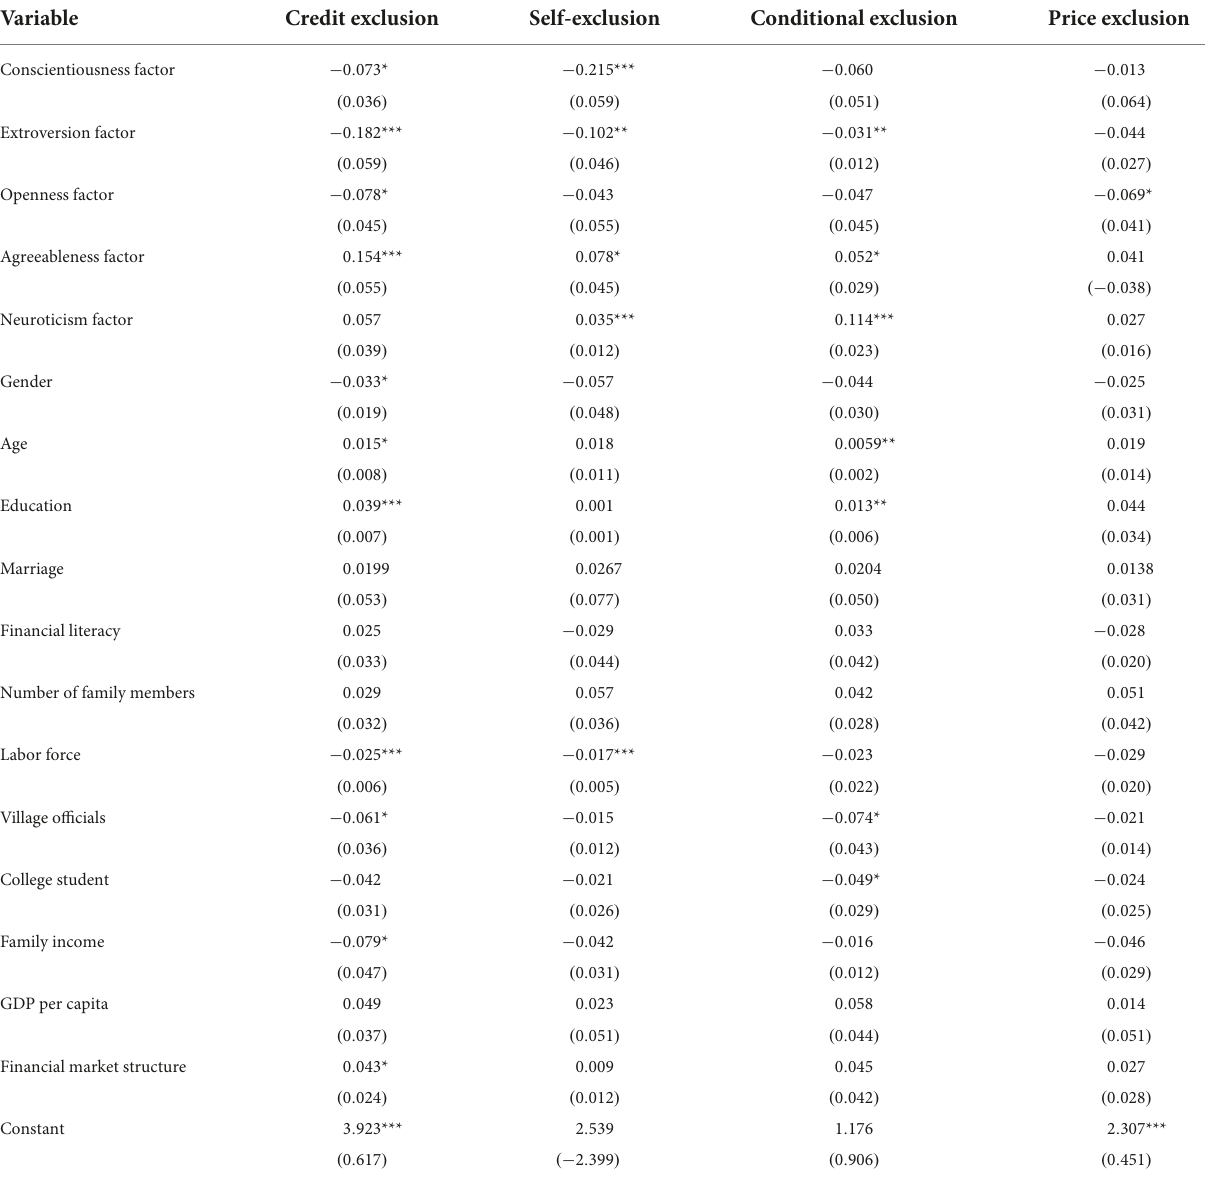
TABLE 6 Baseline